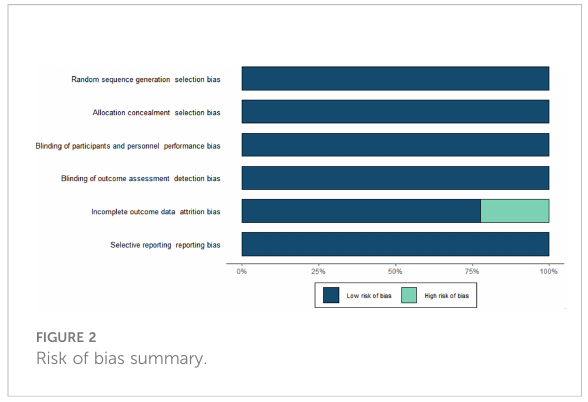
FIGURE 2 Risk of bias summary.